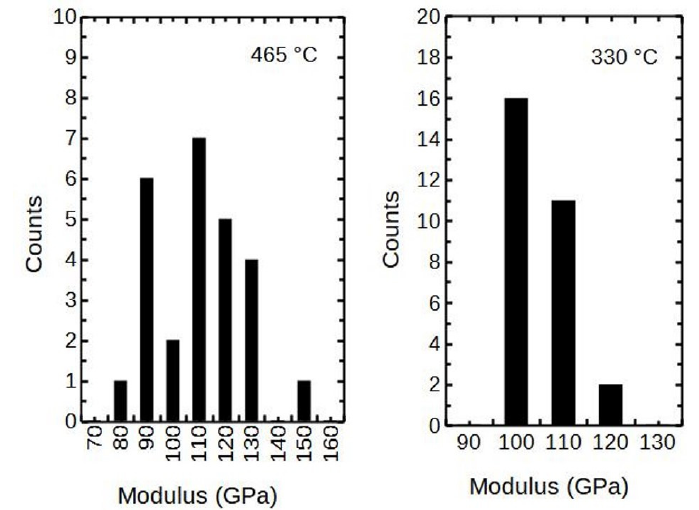
Figure 7. The scatter of modulus measurements of the 85 and 68 nm thick films, respectively.